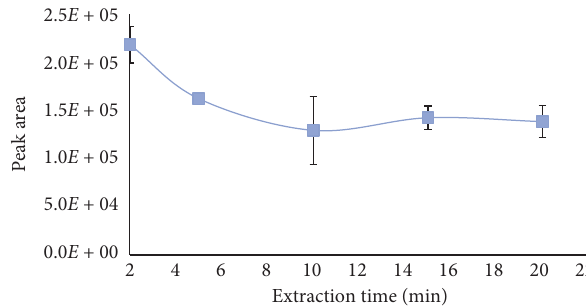
Figure 4: Extraction profile of pregabalin using PME.